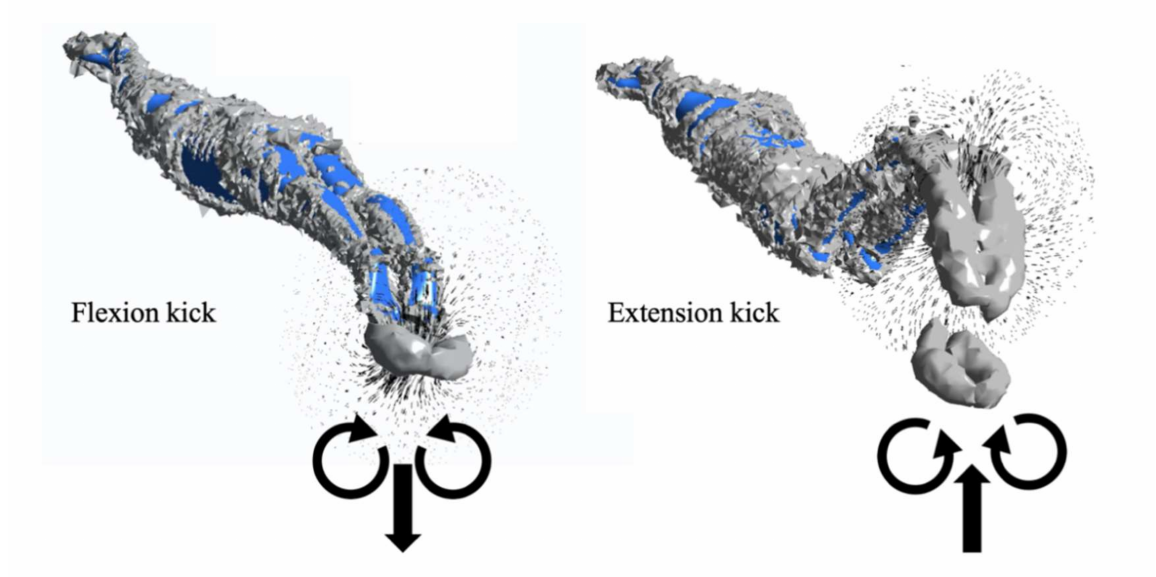
Figure 11. Two counter-rotating vortices and a jet